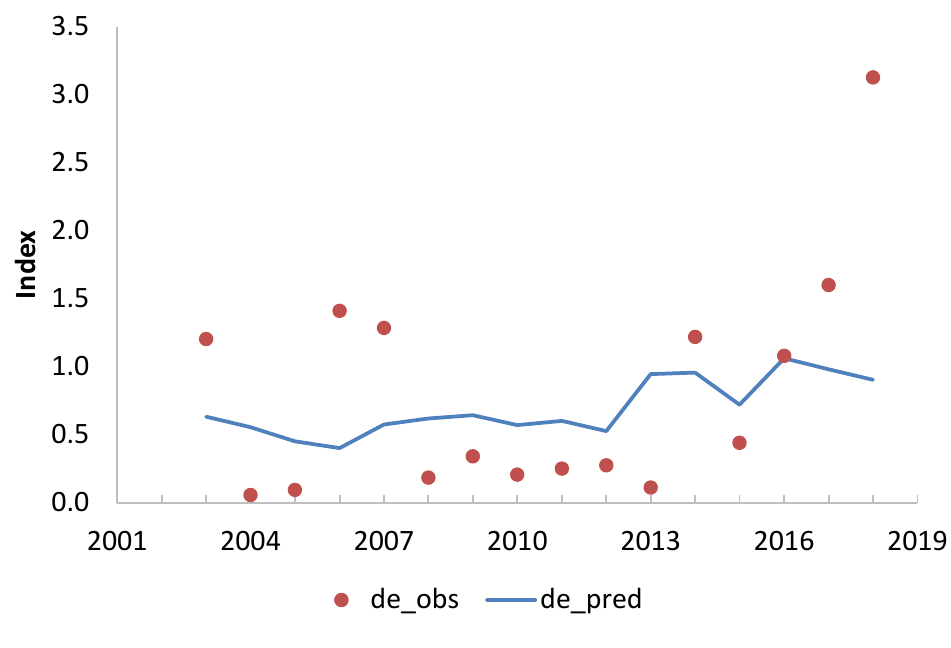
Figure 104. CMSA model fit to Delaware Bay trawl survey aggregate adult female index.